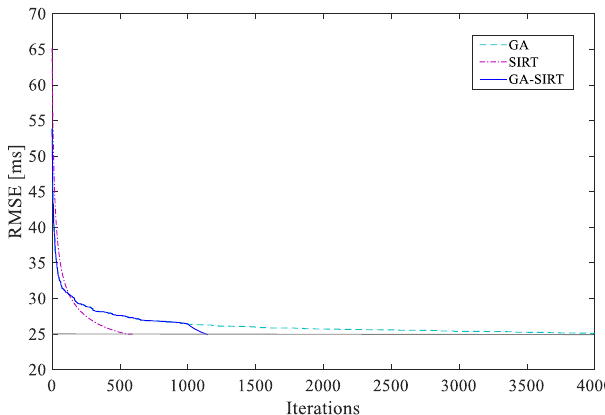
Figure 9. The number of iterations required to achieve the same error (after 25 ms) by the GA, the SIRT, and the GA-SIRT.